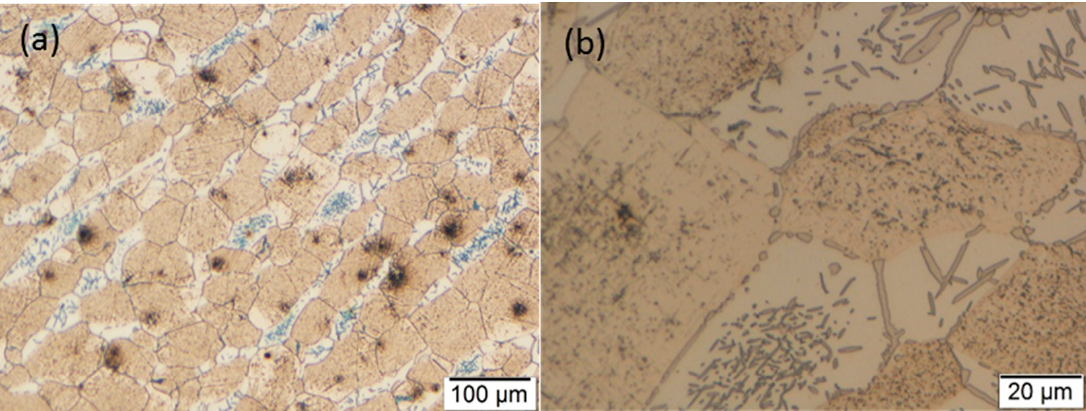
Figure 9. Optical microscopy of the sample that was isothermally annealed at 750 °C, etched with 10% nital, ( a ) ferrite–– white with visible blueish carbide precipitates, and austenite––brown with visible precipitation, ( b ) magnified detail, there is a strong precipitation on the ferrite–ferrite and ferrite–austenite grain boundaries, the carbide film has begun to sphe- roidise.